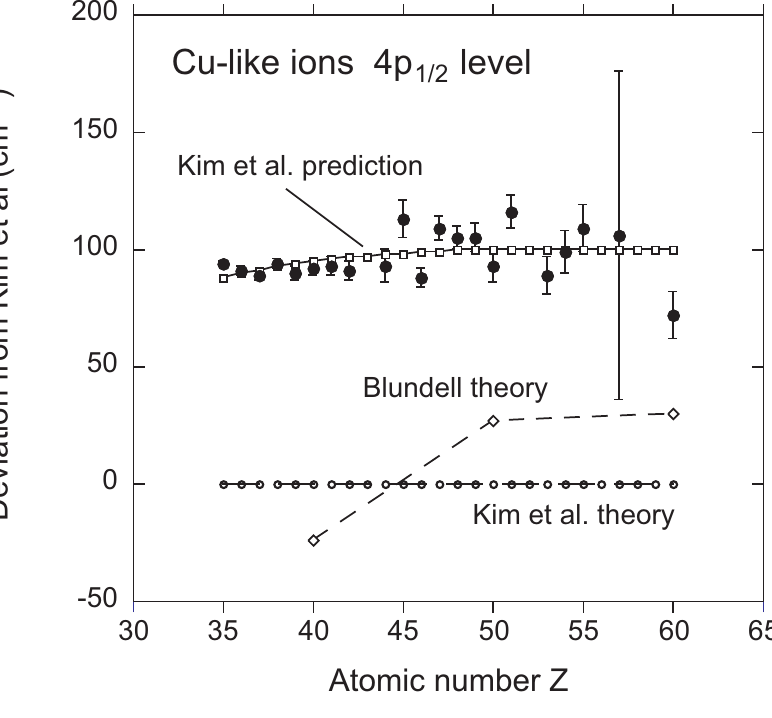
Figure 4. Deviations among calculations by Kim et al. [5] and by Blundell [6] and measurement for the 4p 1/2 level in Cu-like